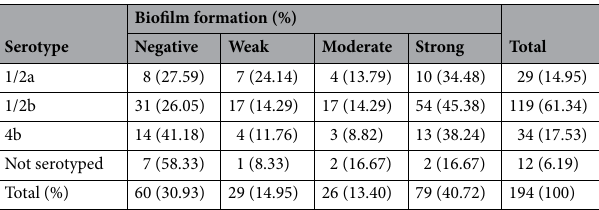
Table 3. Biofilm forming capability of the serotypes observed.